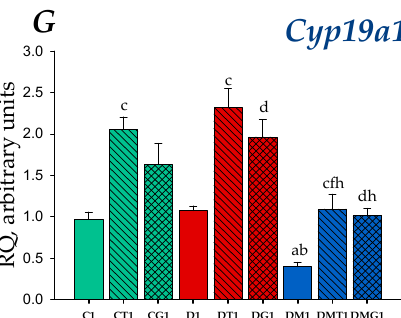
Figure 3. The influence of a single treatment with hCG and TP3 on the expression of testicular genes encoding cholesterol-transporting protein StAR, steroidogenic enzymes and LH/hCG-R in the control and diabetic rats, and the effect of five-week metformin treatment. The duration of MF treatment (120 mg/kg/day) was five weeks. The samples for the assessment of gene expression in the testes were taken 5 h after the injection of LH/hCG-R-agonists. The expression of the following genes is shown in the Figure: Star , encoding cholesterol-transporting protein StAR ( A ); Cyp11a1 ( B ), Hsd3b ( C ), Cyp17a1 ( D ) and Hsd17b ( E ), encoding four steroidogenic enzymes cytochrome P450 scc , 3 β -hy- droxysteroid dehydrogenase, cytochrome P450 17A1/steroid 17 α -monooxigenase and 17 β -hydroxysteroid dehydrogenase that catalyze the synthesis of pregnenolone, progesterone, 17-hydrox- yprogesterone, androstenedione and testosterone; LhR, encoding LH/hCG receptor ( F ); and Cyp19a1 ( G ), encoding aromatase that catalyzes the synthesis of estradiol. a —the difference between the C1 vs. D1 or DM1, b —the difference between the D1 vs. DM1; c —the difference between the C1 vs. CT1, D1 vs. DT1 and DM1 vs. DMT1; d —the difference between the C1 vs. CG1, D1 vs. DG1 and DM1 vs. DMG1; e —the difference between the CT1 vs. CG1, DT1 vs. DG1 and DMT1 vs. DMG1; f —the dif- ference between the CT1 vs. DT1 or DMT1; g —the difference between the CG1 vs. DG1 or DMG1; and h —the difference between the DT1 vs. DMT1 and DG1 vs. DMG1 are significant at p < 0.05. The data are presented as the M ± SEM , n = 5.